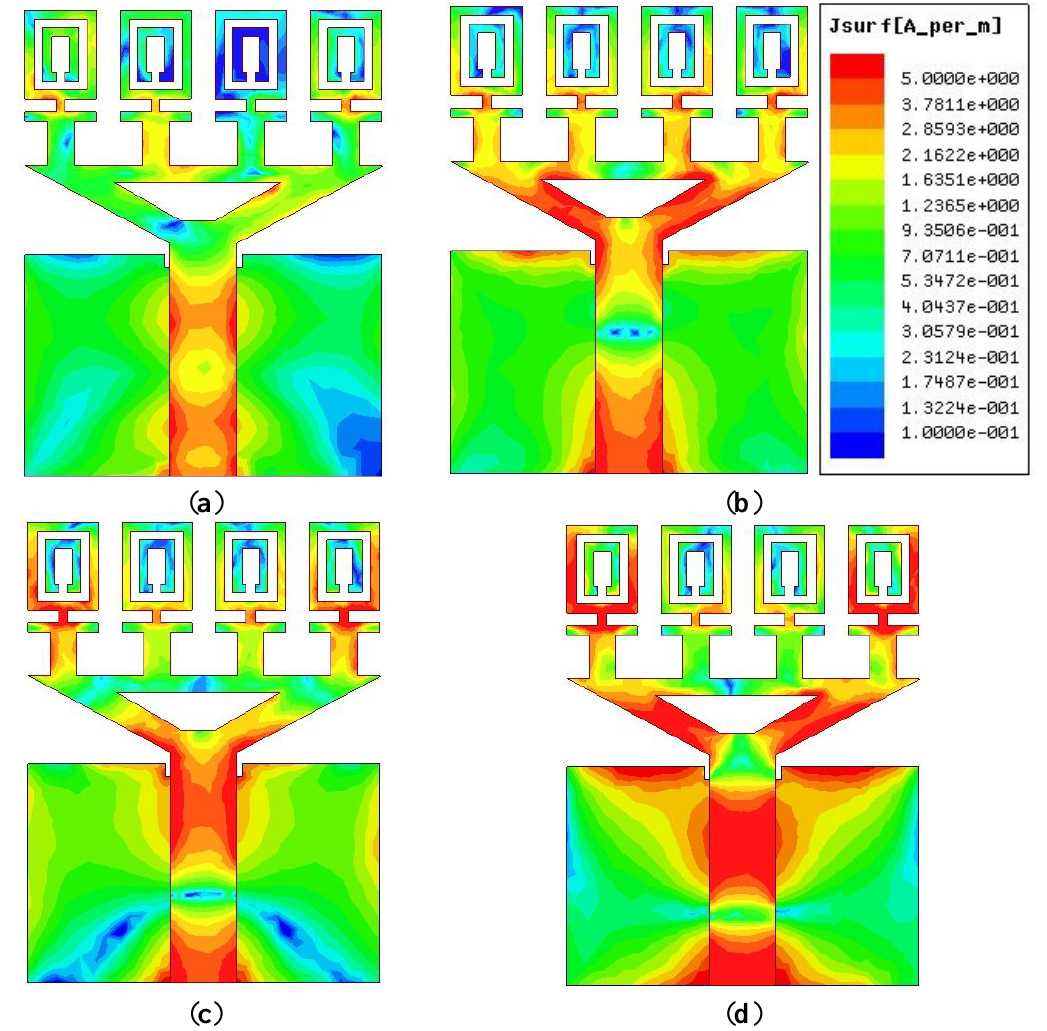
Figure 11. The surface current distribution at ( a ) 4 GHz; ( b ) 6 GHz; ( c ) 9 GHz and ( d ) 12